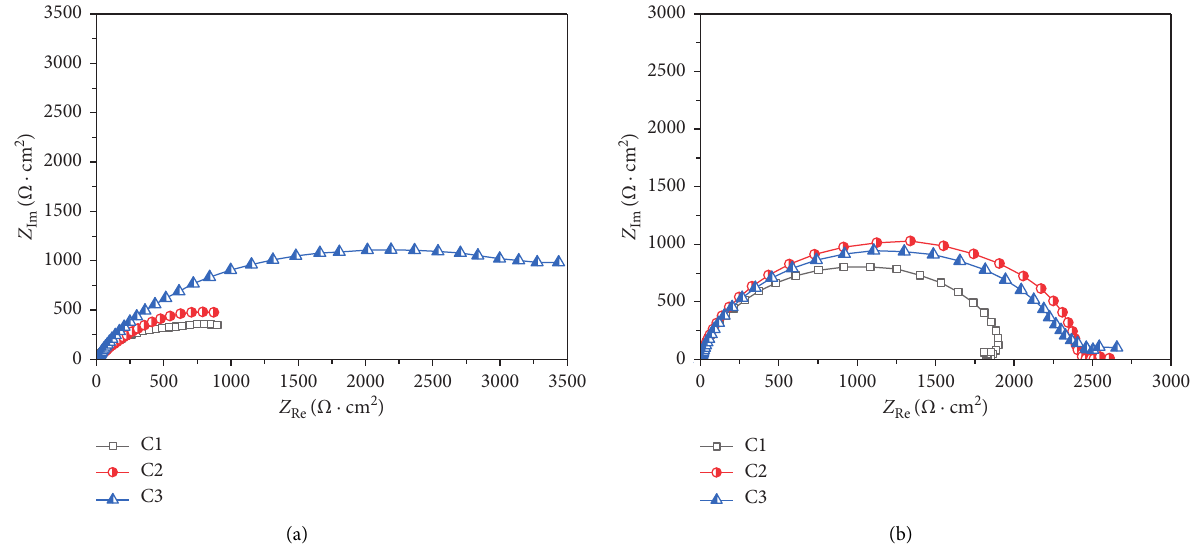
Figure 10: Nyquist plots of as-prepared Ni45 coatings in (a) 0.5M NaCl and (b) 0.5 M NaCl +0.5M H